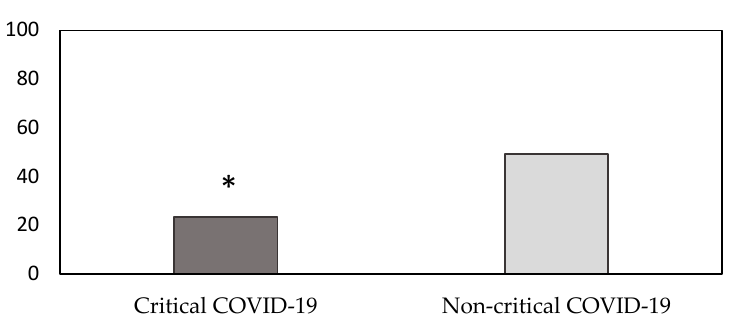
Figure 2. Mean absolute eosinophil count (AEC) in patients with asthma admitted to the ED at our institution, classified as critical or non-critical COVID-19. * = p < 0.05.